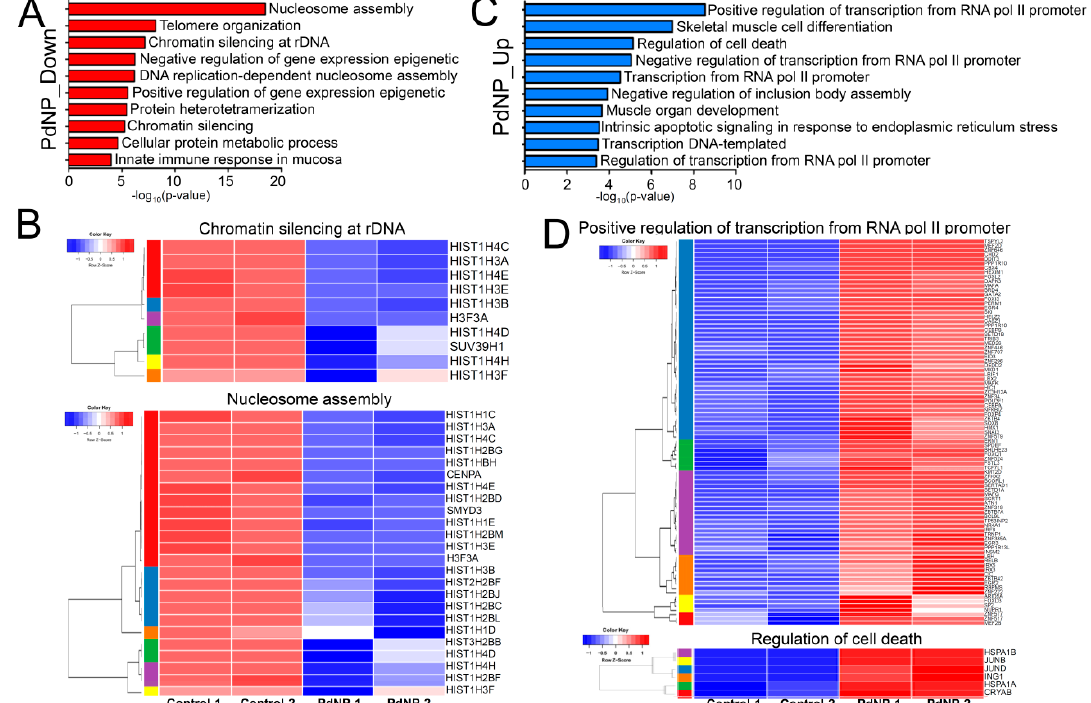
Figure 10. Genes involved in epigenetic and transcriptional regulation are significantly altered by PdNPs treatment. ( A ) Bar graphs showing GO terms enriched in downregulated genes. -log 10 ( p -value) is used. ( B ) Representative heatmaps showing genes in the chromatin silencing at ribosomal DNA and nucleosome assembly GO terms. Note that most of the genes in the GO terms are associated with histone gene clusters. ( C ) Bar graphs showing GO terms enriched in upregulated genes. ( D ) Representative heatmaps showing genes in the GO terms of positive regulation of transcription from RNA polymerase II promoter and regulation of cell death.